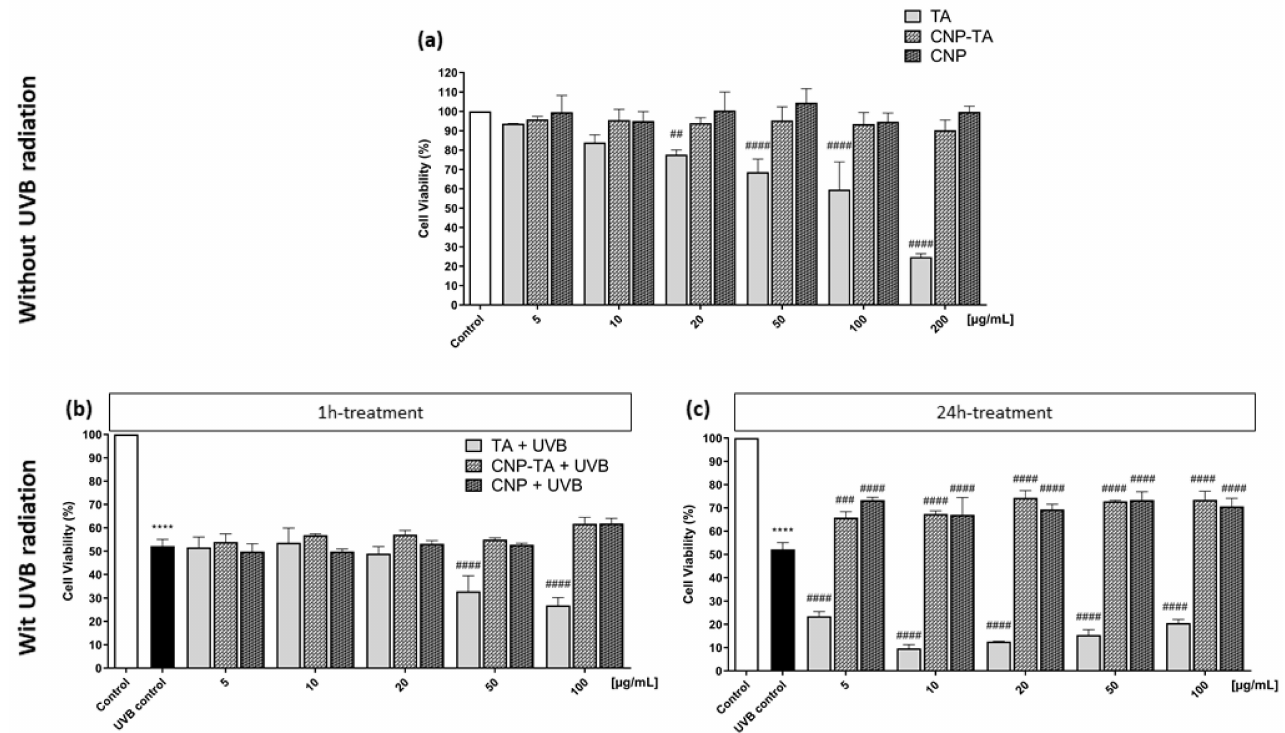
Figure 3. ( a ) Cytotoxicity effect evaluation of L-929 fibroblasts 24 h treated with TA, CNP-TA and CNPs, without UVB exposure. Control: untreated cells. ## p < 0.01 and #### p < 0.0001 compared to the control. ( b , c ) Effect of TA, CNP-TA and CNPs on cell viability in L-929 fibroblasts treated (5, 10, 20, 50 and 100 µ g/mL) and exposed to UVB radiation. ( b ) Cells were treated for 1 h, irradiated and incubated for 24 h; ( c ) Cells were treated for 24 h, irradiated and incubated for an additional 24 h. Control: non-irradiated and untreated cells; UVB control: irradiated and untreated cells. **** p < 0.0001, compared to control, ### p < 0.001 and #### p < 0.0001 compared to UVB